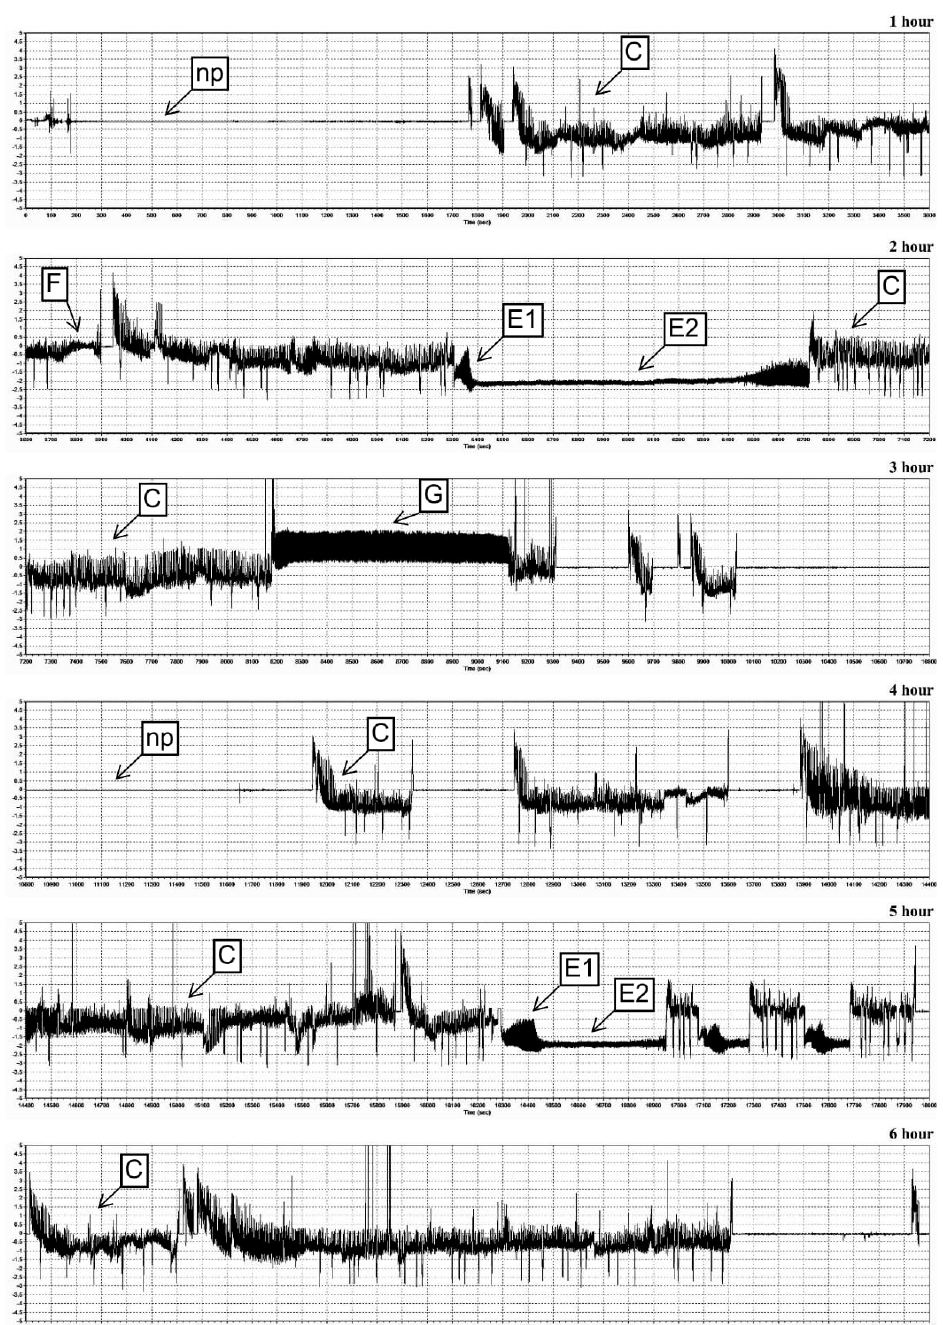
Figure 5. Electrical penetration graph recordings of stylet activities of M. dirhodum females in the maize seedling leaves of relatively resistant Waza cv. Y-axis—amplitude (mV); X-axis—time (s); np—non-probing; C—transition of stylet in epidermis and mesophyll cells; E1—salivation into sieve elements; E2—phloem sap ingestion; F—difficulties in stylet penetrations in host plant tissues; G—xylem sap uptake.